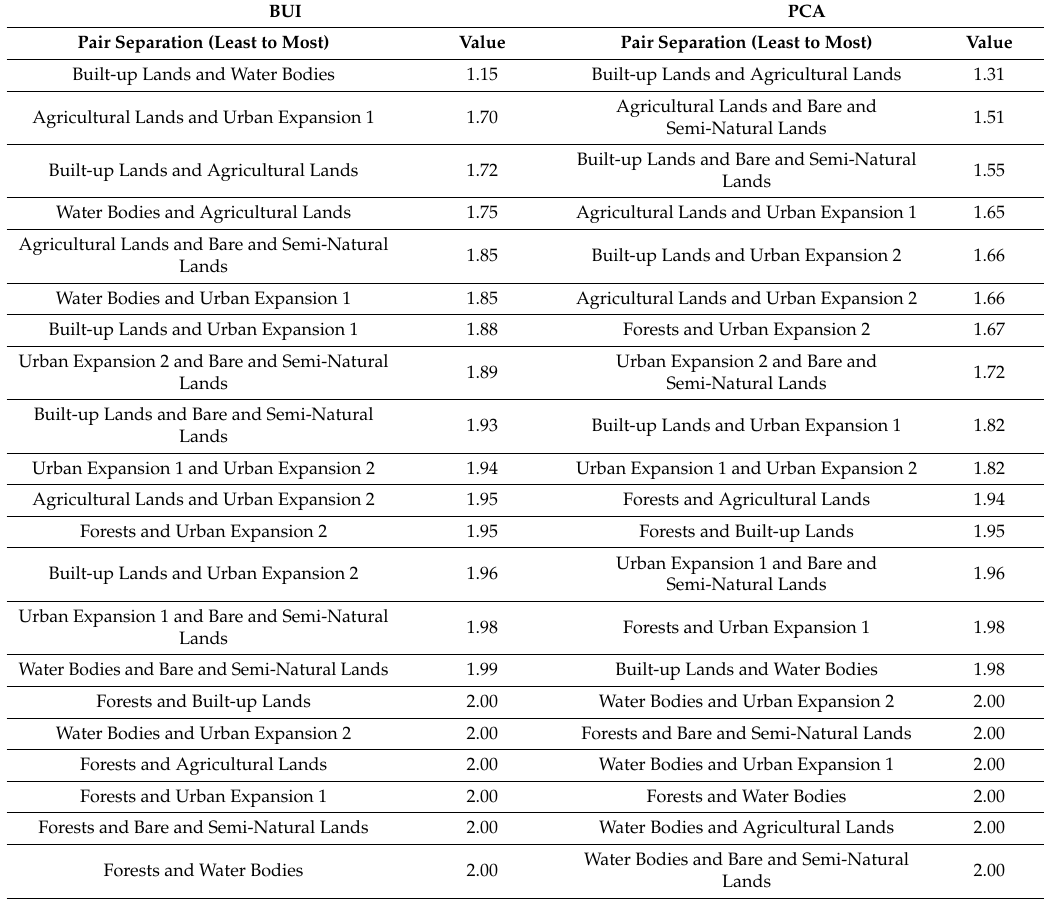
Table A1. Separation metrics derived from training samples for the BUI and PCA datasets. BUI PCA Pair Separation (Least to Most) Value Pair Separation (Least to Most)